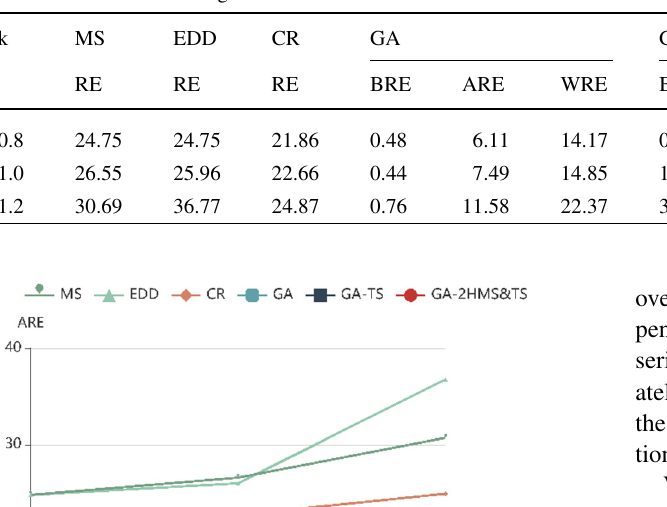
Table 9 RE of different algorithms for different road conditions